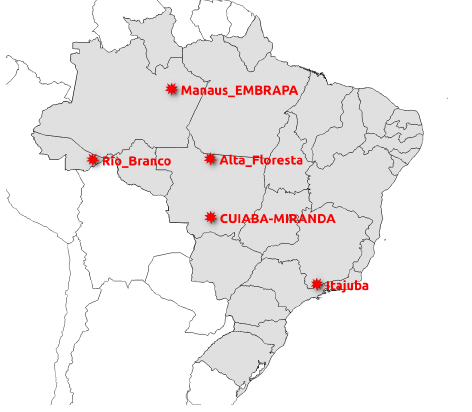
Figure 1. Five AERONET stations: Alta Floresta, Cuiab´a-Miranda, Manaus-EMBRAPA, Itajub´a and Rio Branco, over Brazilian territory.